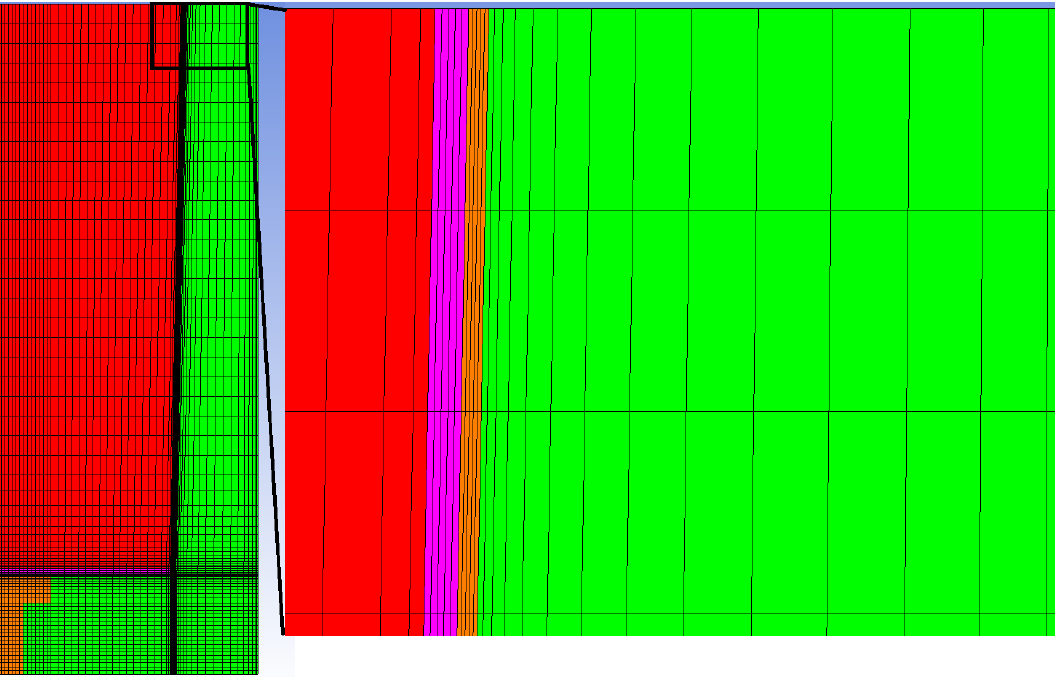
Figure A4. CFD mesh used in the 2D axisymmetric simulations. Mesh details of the slag/slag mould/air gap/cooling mould are depicted on the right.